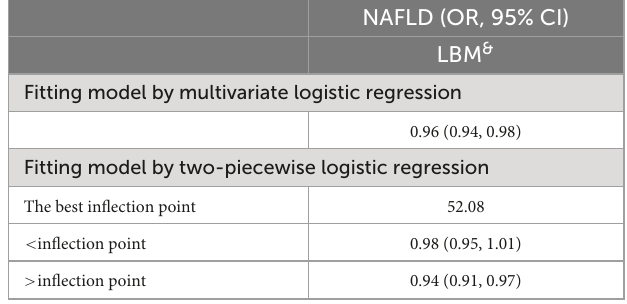
TABLE 4 Piecewise logistic regression examining thresholds for predicted lean body mass (LBM)-related non-alcoholic fatty liver disease (NAFLD) risk in